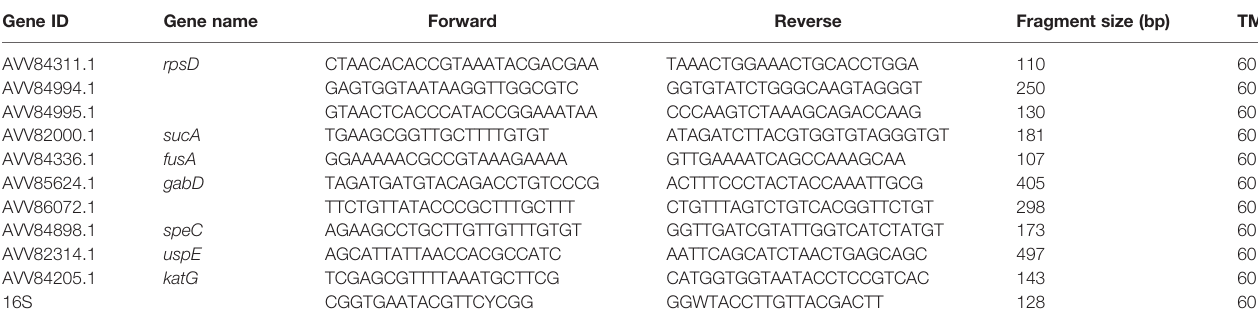
TABLE 1 | Genes and primers used in the qRT-PCR